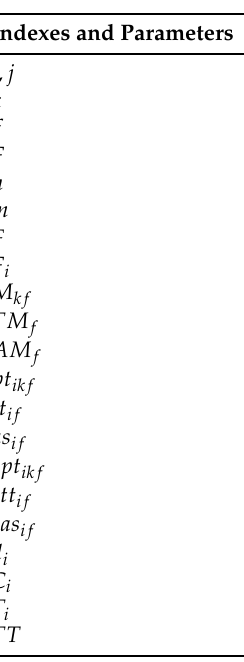
Table 1. A summary of